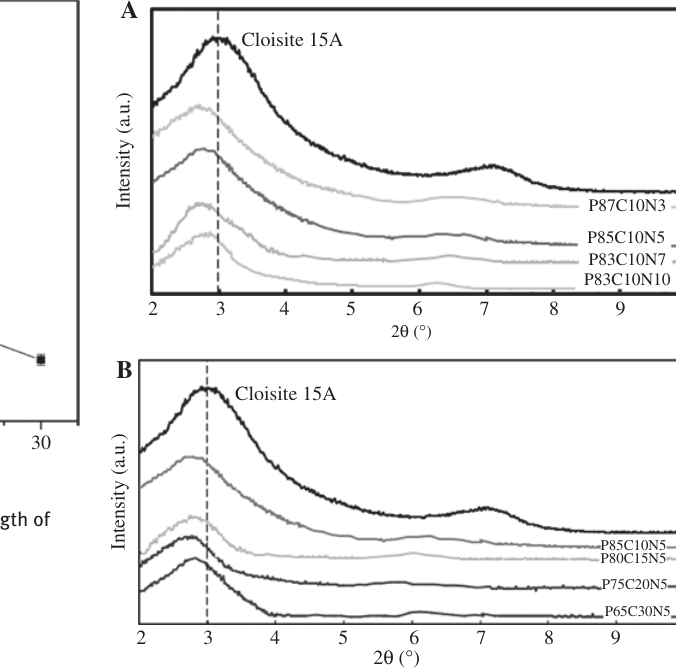
Figure 5: XRD patterns of PP/PC nanocomposites in which (A) The concentration of dispersed phase (PC) kept constant and equal to 10 wt% and (B) the concentration of NC (Cloisite 15A) kept constant and equal to 5 wt%.